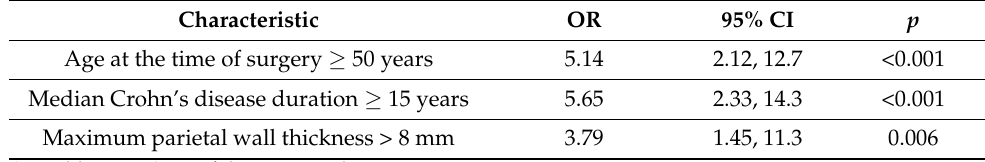
Table 7. Predictors of SBA in multivariable and Cox regression analyses.